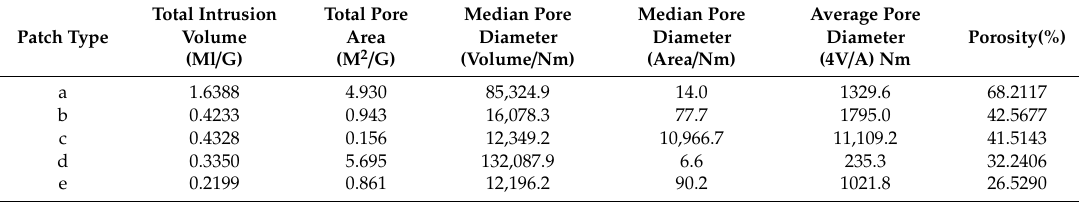
Table 2. Porosity of Centella asiatica extract (CAE)-loaded hyaluronic acid-dextran (HA-Dex) hybrid hydrogel patches.